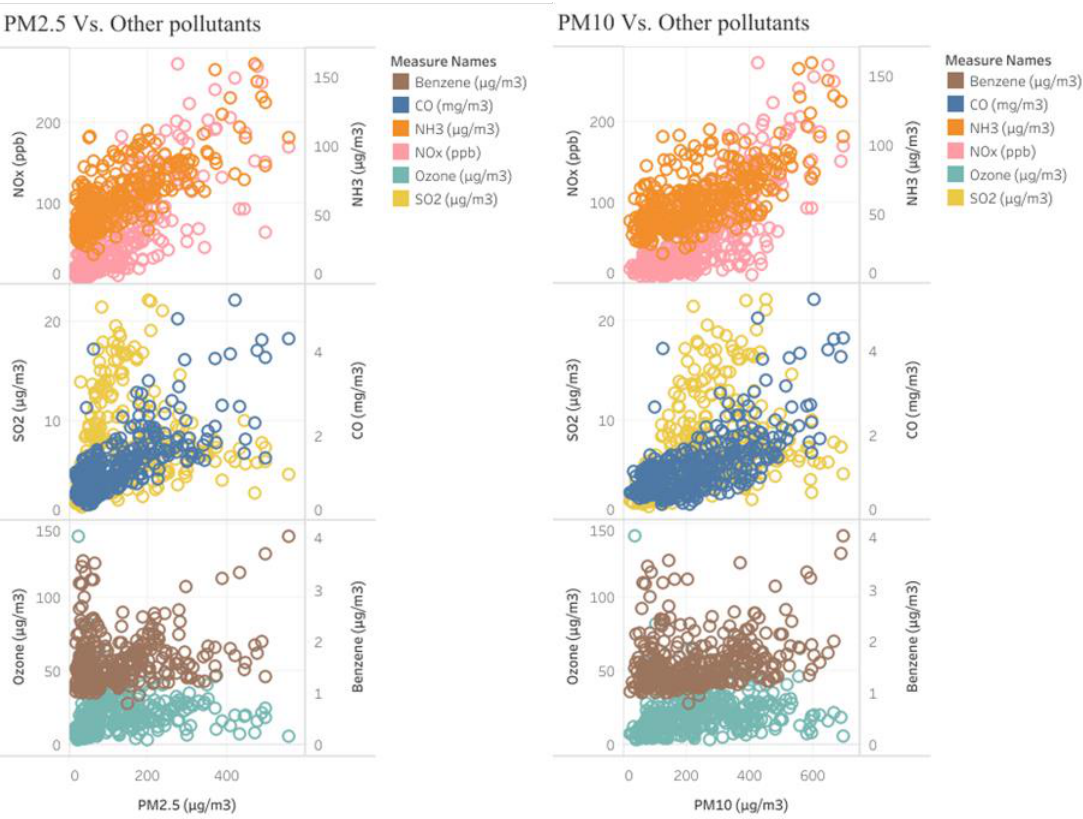
Figure 3. Correlation analysis of PMs with other pollutants.